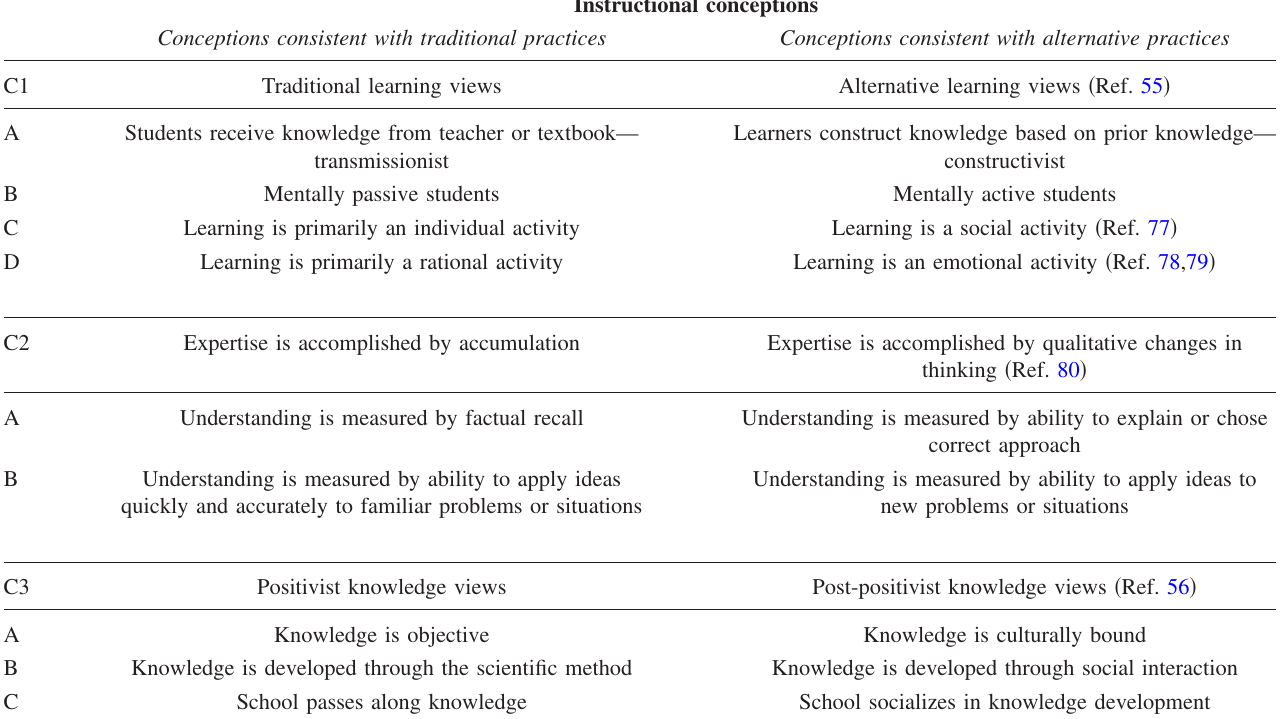
TABLE VI. Conception categories of the framework. Instructional